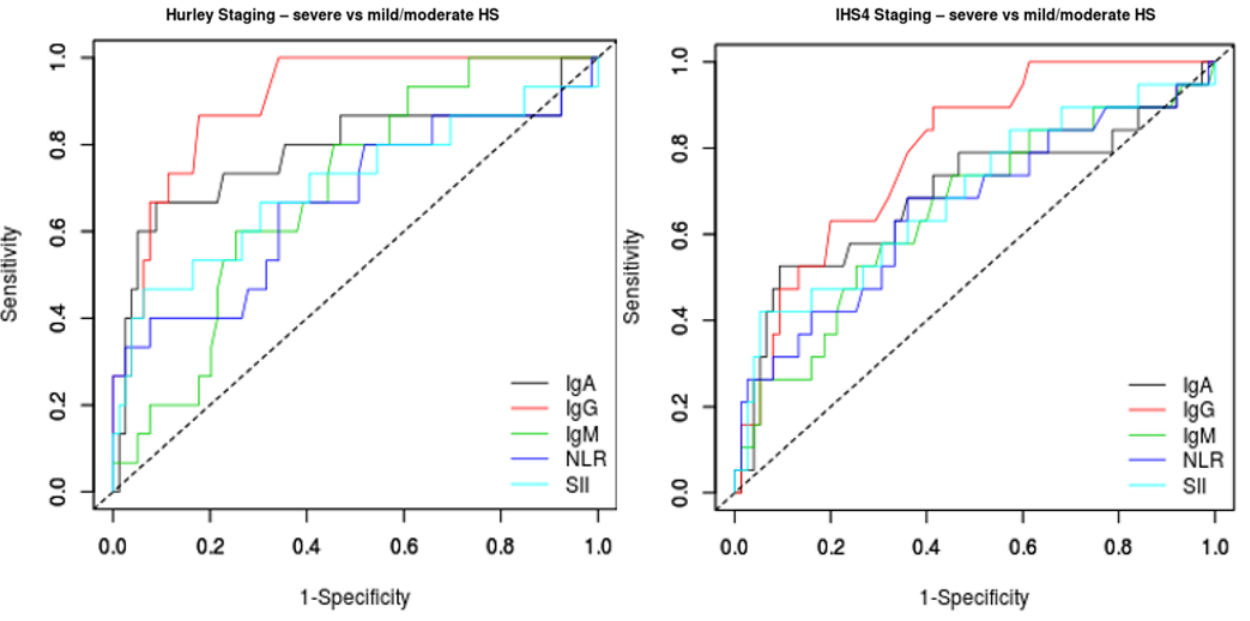
Figure 4. Comparison of ROC curves for IgA, IgG, IgM, neutrophil–lymphocyte ratio (NLR) and systemic immune-inflammation index (SII), with severe disease as the status variable. IgG levels demonstrate stronger discriminatory value for severe disease when compared to other blood-based indices of inflammation, such as the NLR and SII. Table 3. Comparison of area under the curve (AUC) values for IgG IgM, IgA, NLR and SII, with severe disease as the status variable. IgG levels demonstrated stronger discriminatory value for severe disease when compared to other blood-based indices of inflammation, such as the NLR and SII, using both Hurley and IHS4 classifications. The top panel depicts receiver operating characteristic (ROC) analysis with subjects having mild and moderate disease, considered an aggregate reference category. Exclusion of subjects with moderate disease (bottom panel) yielded consistent findings. Hurley Severe vs. Hurley Moderate/Mild IHS4 Severe vs. IHS4